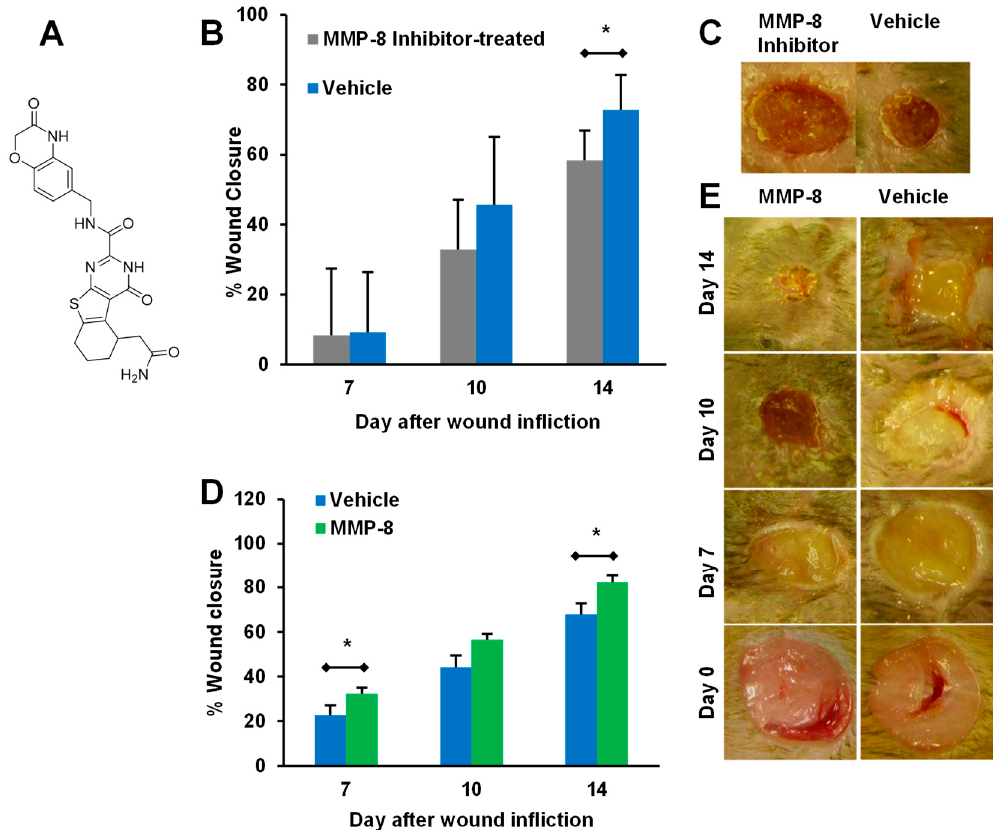
Figure 5. The role of MMP-8 in diabetic wound healing. ( A ) Structure of selective MMP-8 inhibitor. ( B and C ) Topical treatment with selective MMP-8 inhibitor (250 μ g/wound/day) delays healing in diabetic mice; mean ± SD, n = 12, 6, and 6 on days 7, 10, and 14, respectively; * p < 0.05. ( D and E ) Topical treatment with exogenous recombinant MMP-8 (1 μ g/wound/day) accelerates diabetic wound healing; mean ± SEM, n = 20, 9, and 9 mice on days 7, 10, and 14, respectively, for the vehicle group; n = 20, 10, and 10 mice on days 7, 10, and 14, respectively, for the MMP-8 group; * p < 0.05. Adapted from Gooyit et al. [67] and Gao et al. [86].